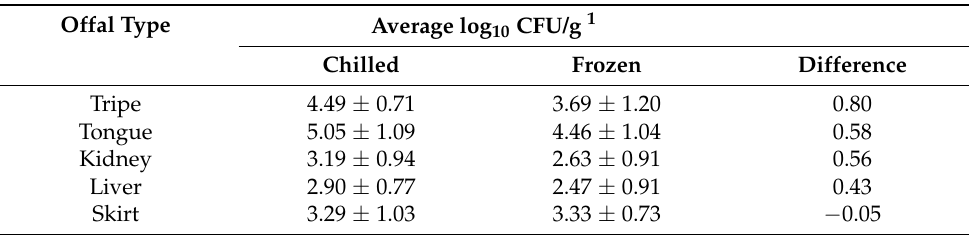
Table 5. APC on offal samples (all species combined) collected chilled or frozen. Only counts for offal types where more than 30 samples were analysed from both frozen and chilled